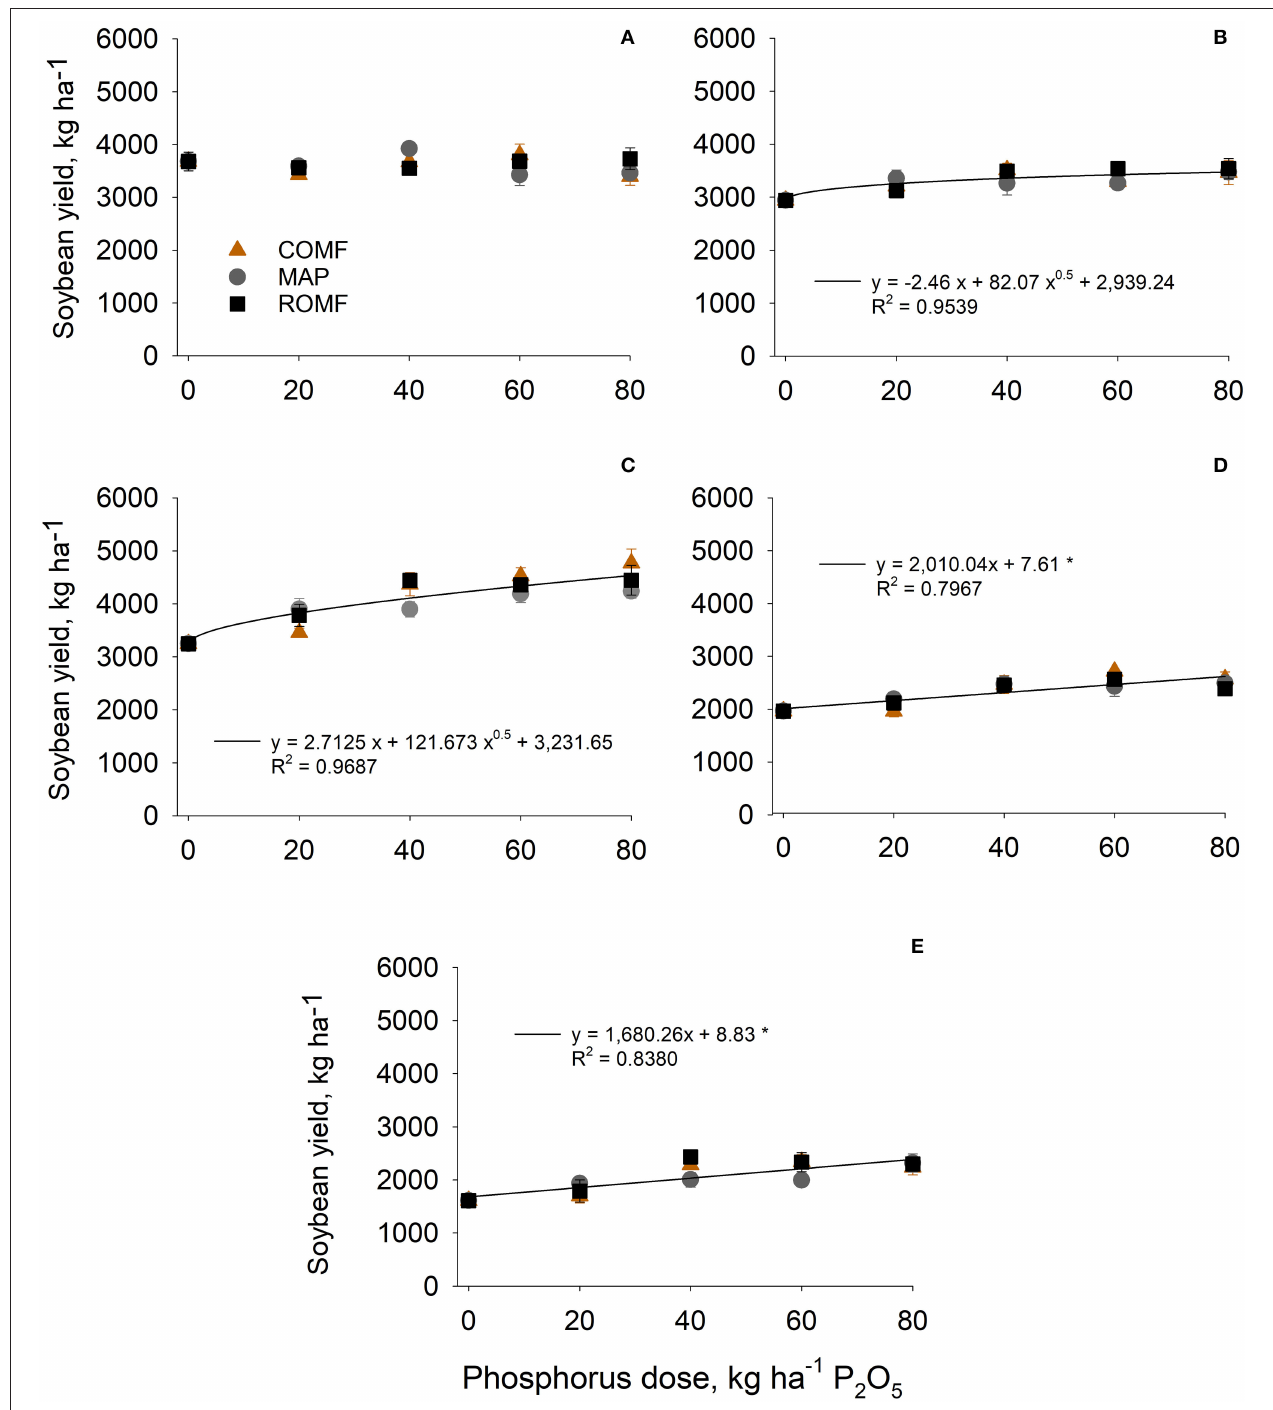
FIGURE 2 | Soybean grain yield from treatments with different fertilizers sources and P doses in the crop seasons 2010/2011 (A) , 2011/2012 (B) , 2012/2013 (C) , 2013/2014 (D) , and 2014/2015 (E) . COMF, composted organomineral fertilizer; MAP, monoammonium phosphate; ROMF, raw poultry litter organomineral fertilizer.